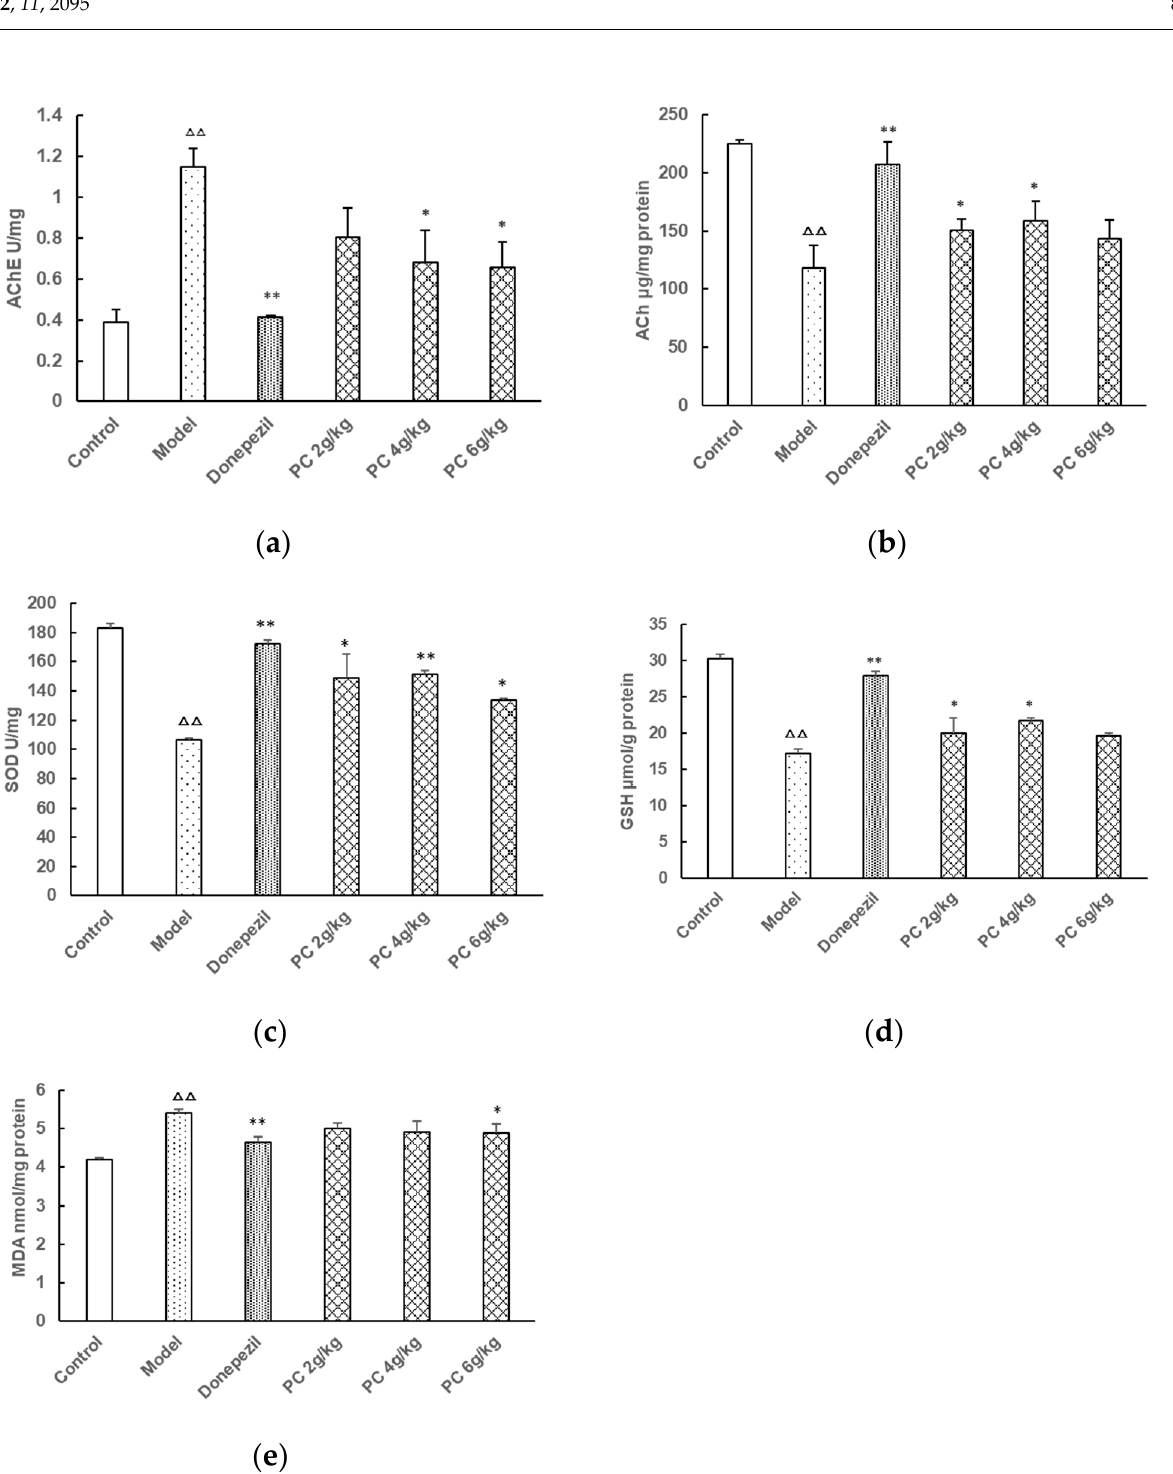
( d ) Figure 4. Mice’s performance in probe trials in the MWM (day 29). ( a ) escape latency, ( b ) crossings of the platform, ( c ) swimming distance in the target quadrant, and ( d ) the time spent in the target quadrant. A total of 60 qualified mice were randomly divided into six groups of 10 animals each, the control (0.5% CMC-Na solution, 0.2 mL/10 g), the model (0.5% CMC-Na solution, 0.2 mL/10 g), donepezil (3 mg/kg), and PC low- (2 g/kg), medium- (4 g/kg), and high- (6 g/kg) dose groups. All groups were administered daily i.g. for 28 consecutive days. The probe trials lasted 1 day after the acquisition (day29). The data represents the mean ± SD. (vs control: ∆∆ , p < 0.01; vs. model: *, p < 0.05, **, p < 0.01). 3.3. Levels of AChE, Ach, SOD, GSH, and MDA Compared to the model group, the AChE activities of the medium- and high-dose PC groups were significantly reduced ( p < 0.05) (Figure 5a). Additionally, the ACh levels in the low- and medium-dose PC groups were significantly increased ( p < 0.05, Figure 5b). The results showed that PC significantly suppressed the activity of AChE, resulting in an increase in the level of ACh in the brains of mice. Compared to the model group, the SOD activities of all the PC-treated groups, and the low-, medium-, and high-doses signifi- cantly increased ( p < 0.05, Figure 5c). Furthermore, the GSH content of the low- and me-